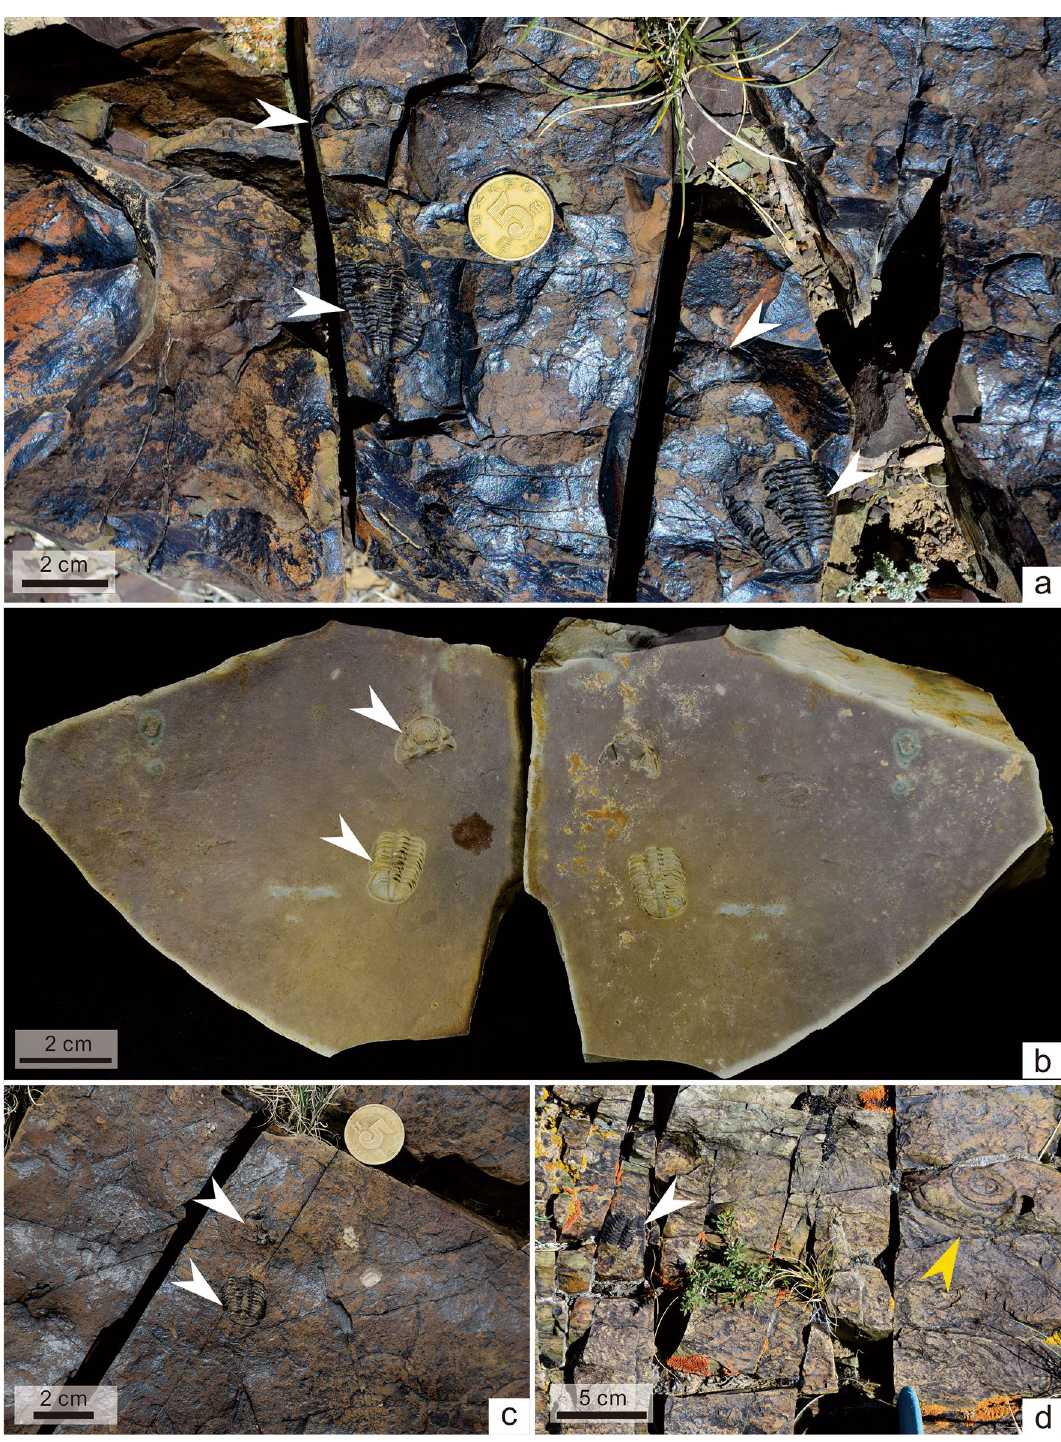
Figure 3. Omegops sp. A (white arrows) preserved in the tuffites of the middle part of the MHF, with no other benthic fossils in the same beds. ( a, c ) from the Wulankeshun section and ( b ) from the Bulonguoer section (BGEG-WJ18-07). ( d ) Omegops sp. A and ammonoids (yellow arrow) on the bedding surface of tuffites. ( a , c , and d ) are field